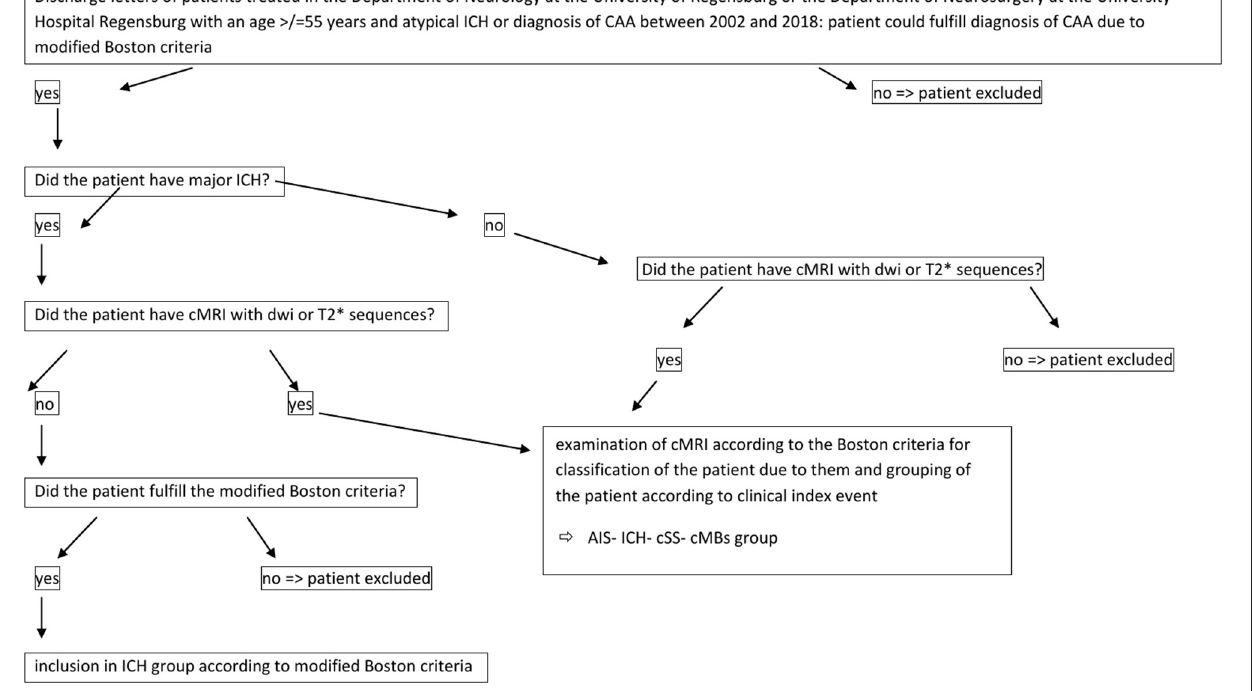
FIGURE 1 | Figure resuming data